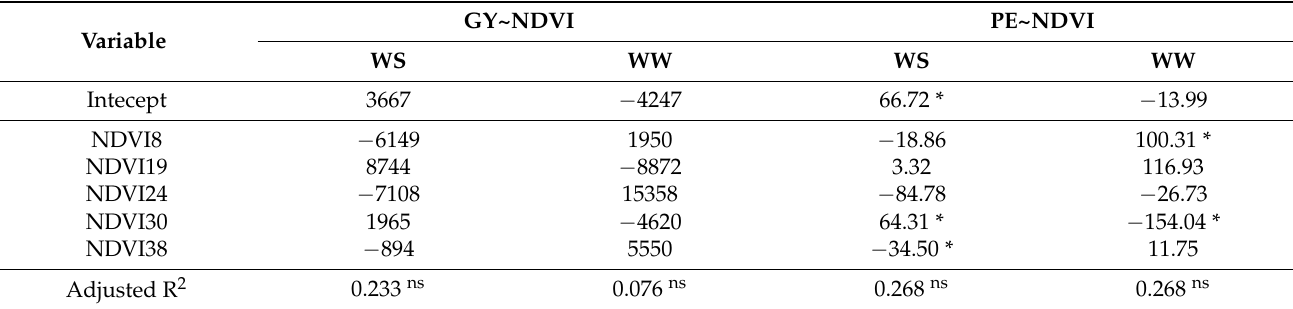
WS = water-stressed, WW = well-watered, NDVI at 8–38 = Normalized Difference Vegetation Index at 8, 19, 24, 30 and 38 days after male anthesis, respectively. * and ns corresponds to the significance at the levels of 5% of probability and no significance by the t -test for the variables and the F test for the models.